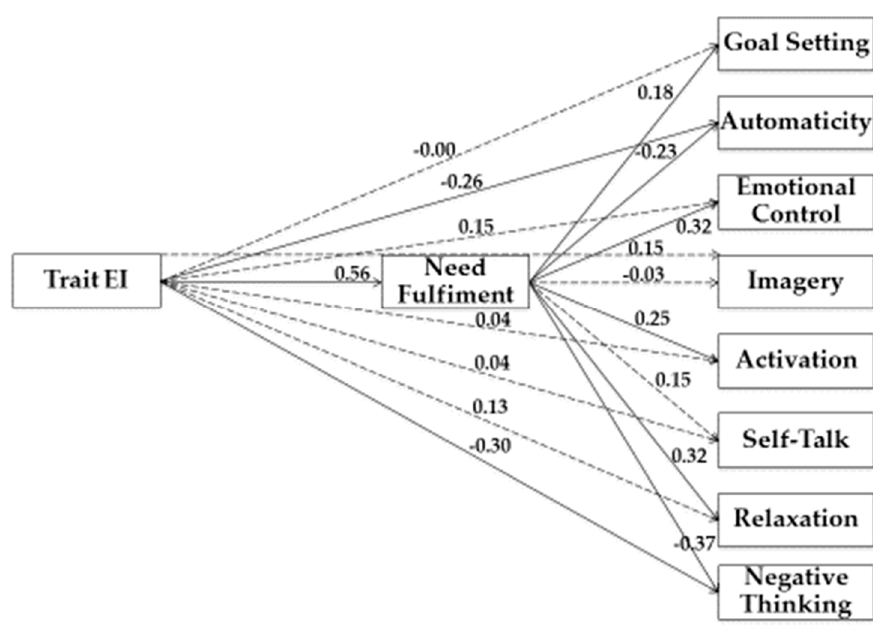
Figure 4. Structural model of associations between Trait EI, Need Fulfiment, and competition strategies. Note: Coefficients shown are standardized path coefficients. Dotted lines represent non-significant relations.